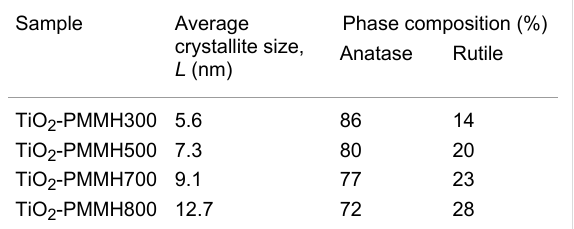
Table 2: Average crystallite size and phase composition of the TiO 2 - PMM Н x samples (see Experimental sections for a description of the sample